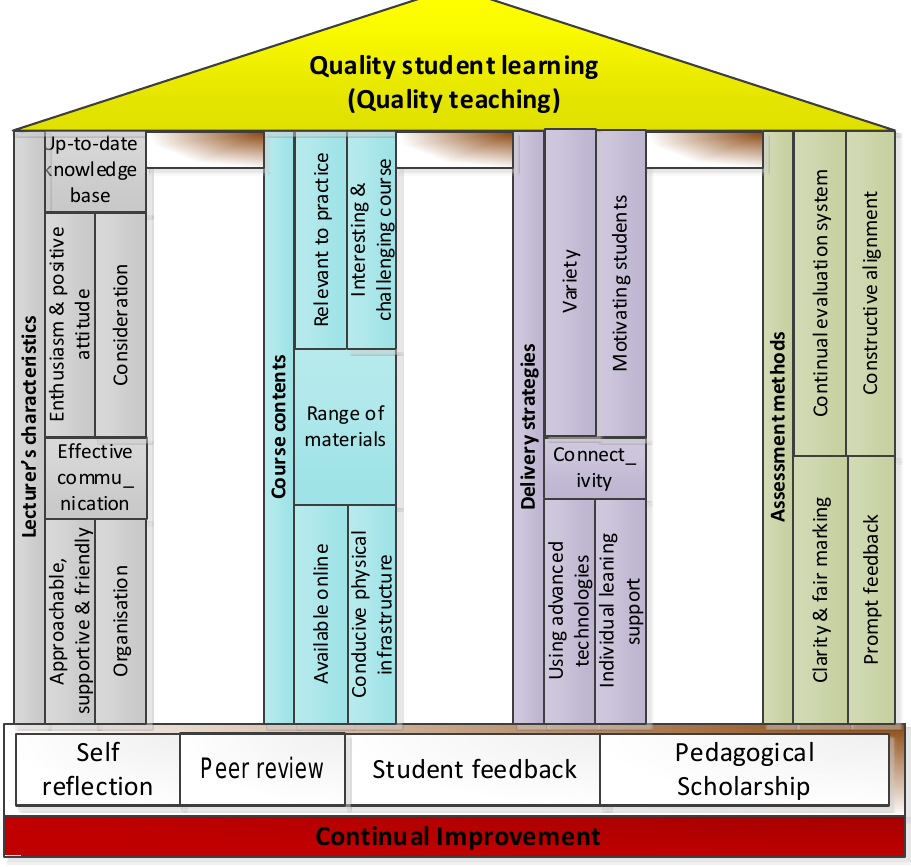
Figure 2: Model for critically reflective teaching